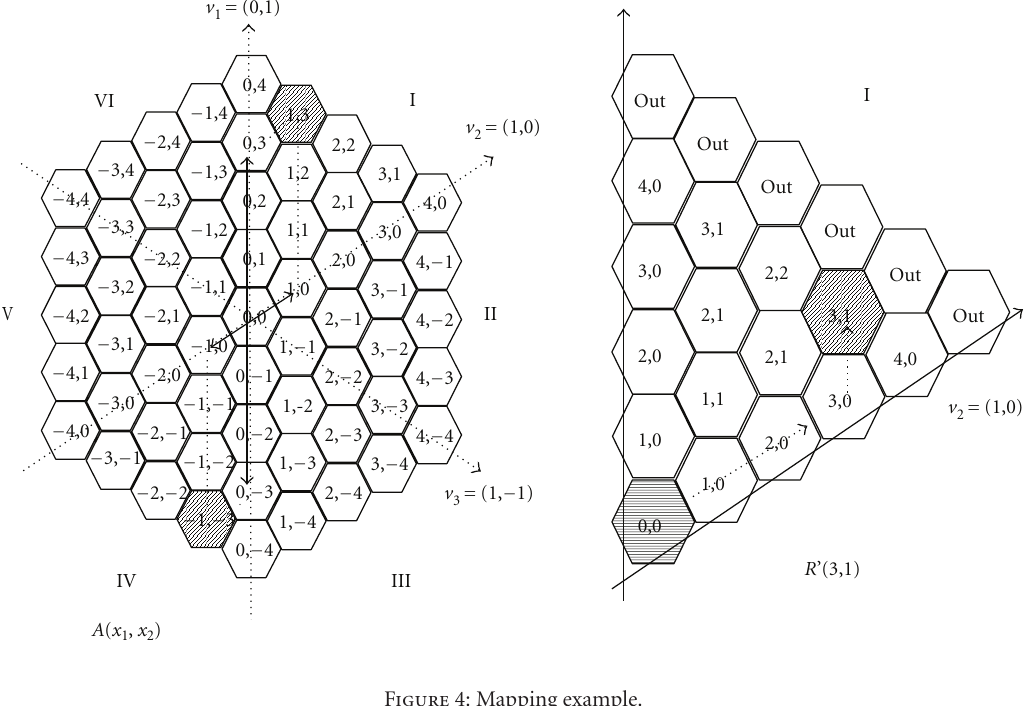
Figure 4: Mapping